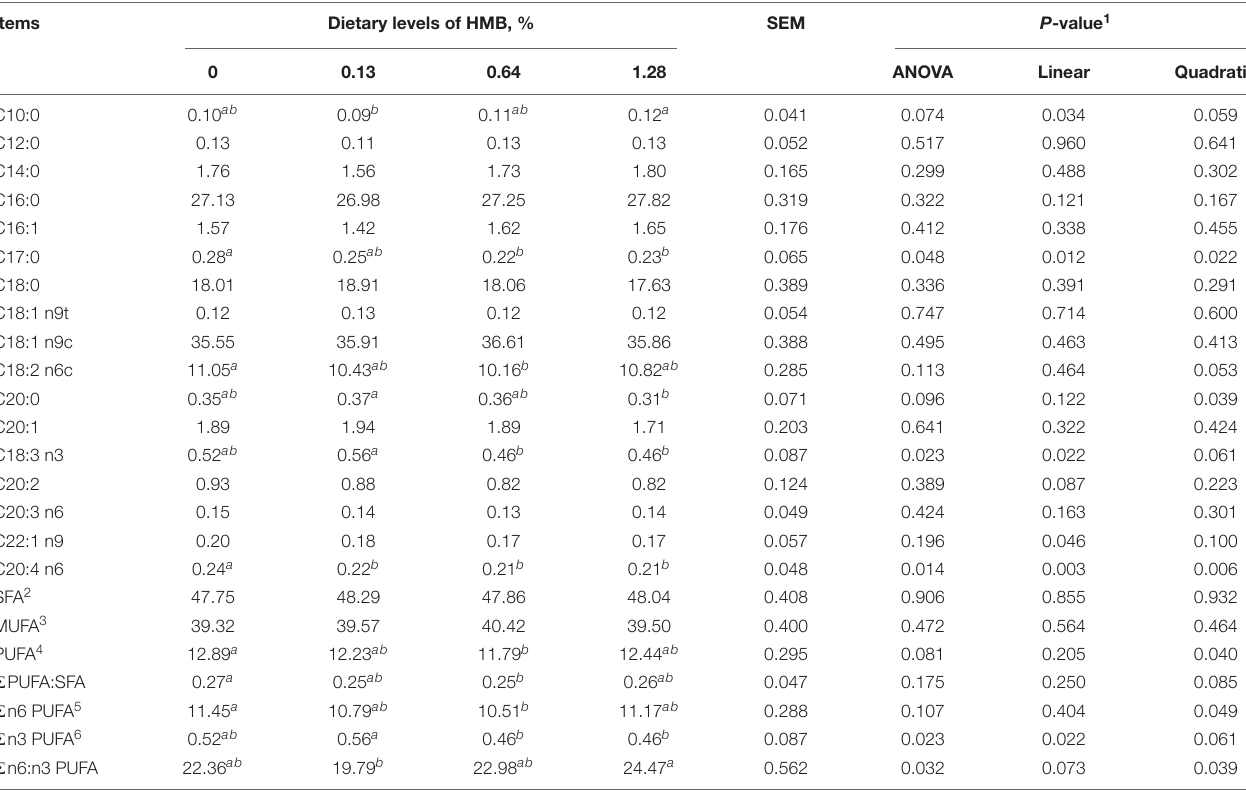
TABLE 1 | Fatty acid composition of dorsal subcutaneous adipose tissue in Bama Xiang mini-pigs fed the diets with various levels of HMB (% of total fatty